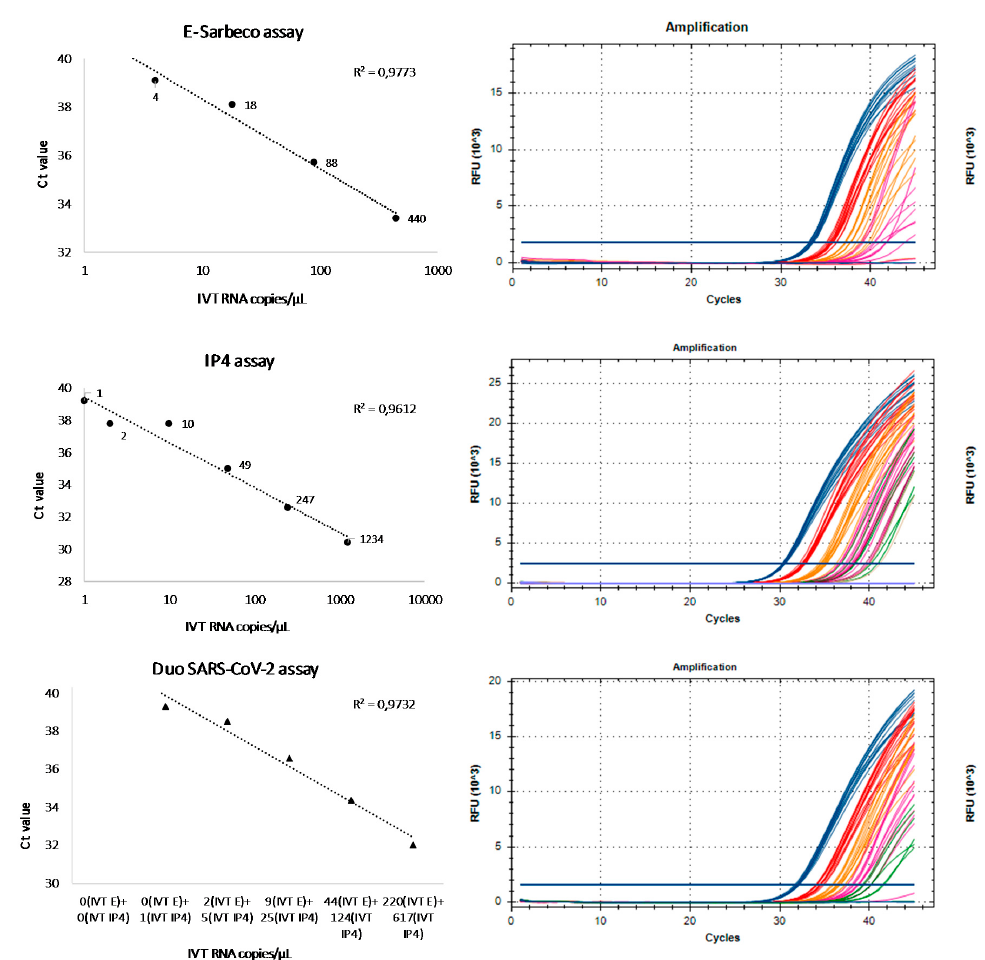
Figure 2. Linearity and signal intensity of E-Sarbeco, RdRp-IP4 and duo SARS-CoV-2 assays.